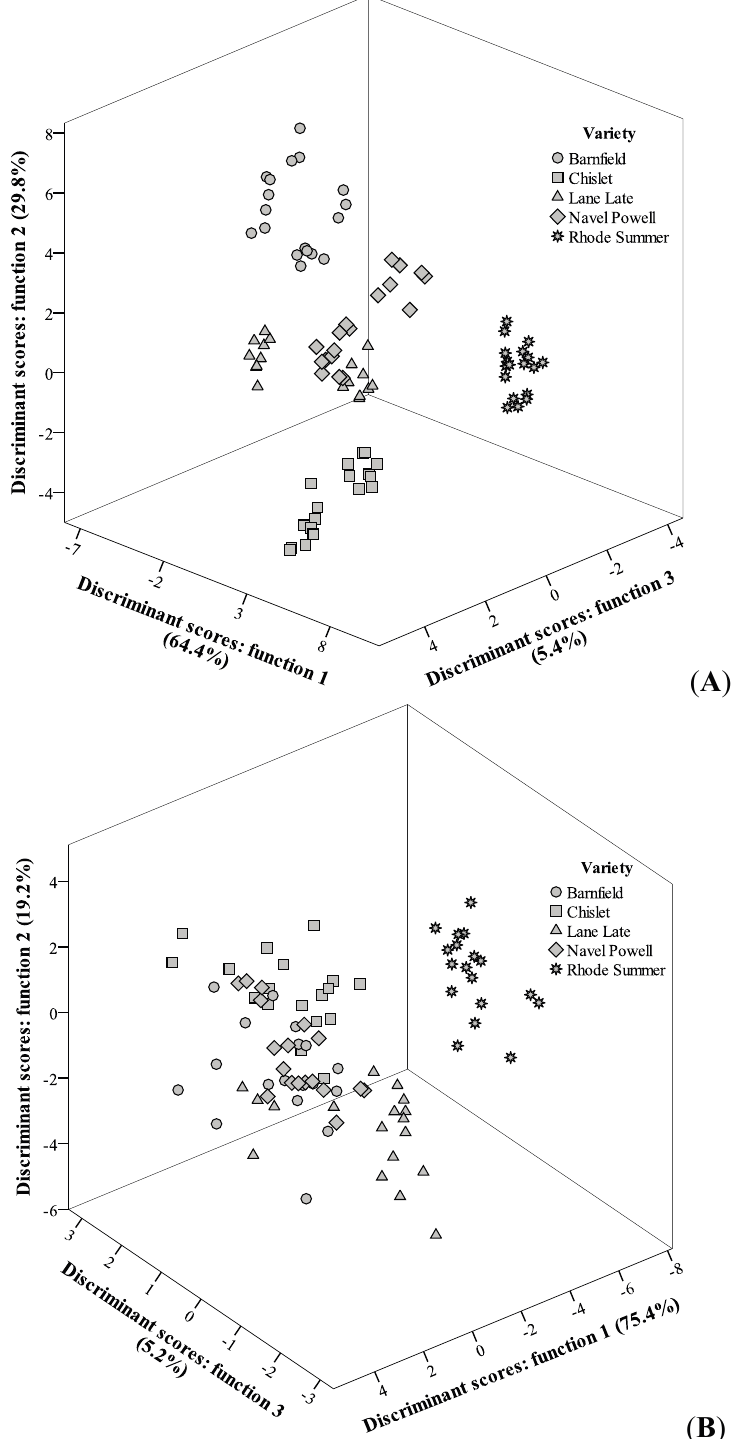
Figure 5. Discriminant scores scatter plot of the canonical functions defined for antioxidant parameters results according with OV for the years 2011 ( A ) and 2012 ( B